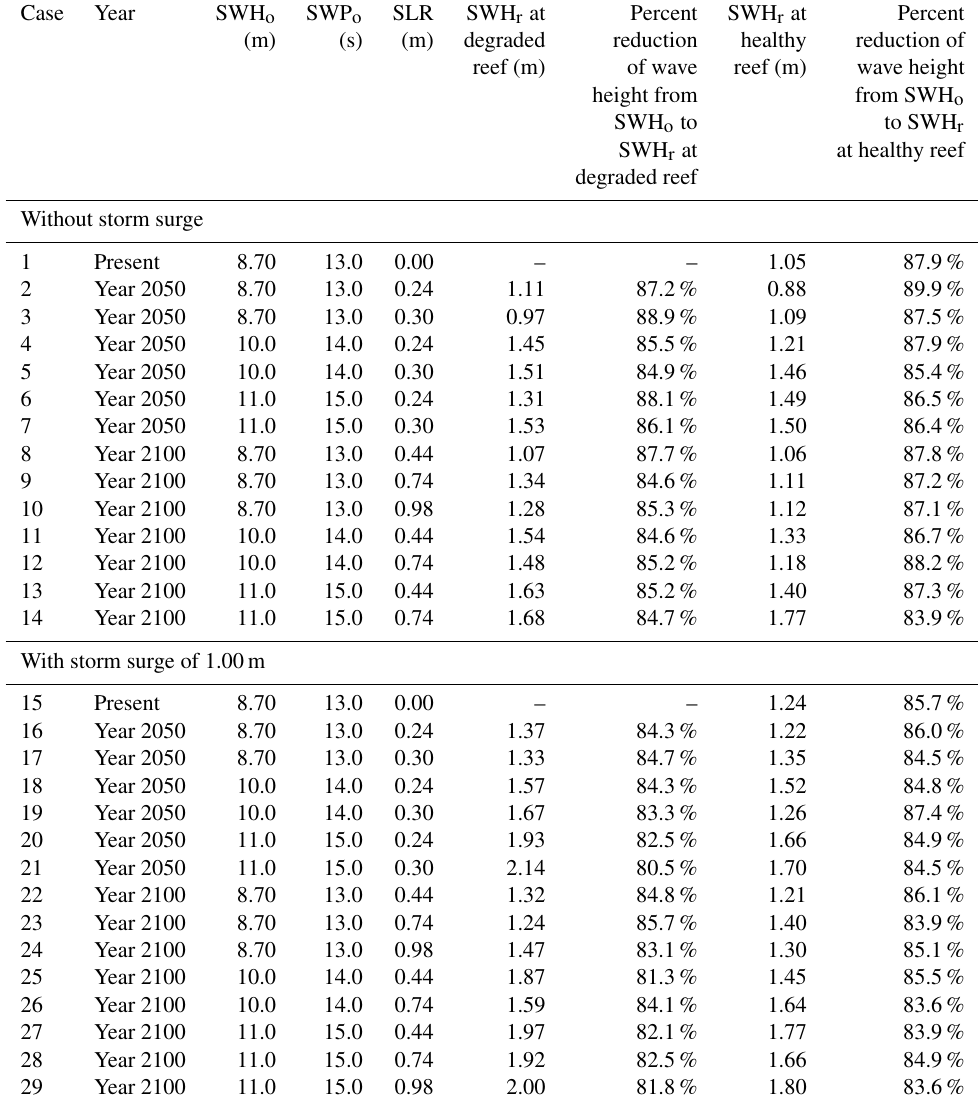
Table 3. Significant wave heights at the study site.